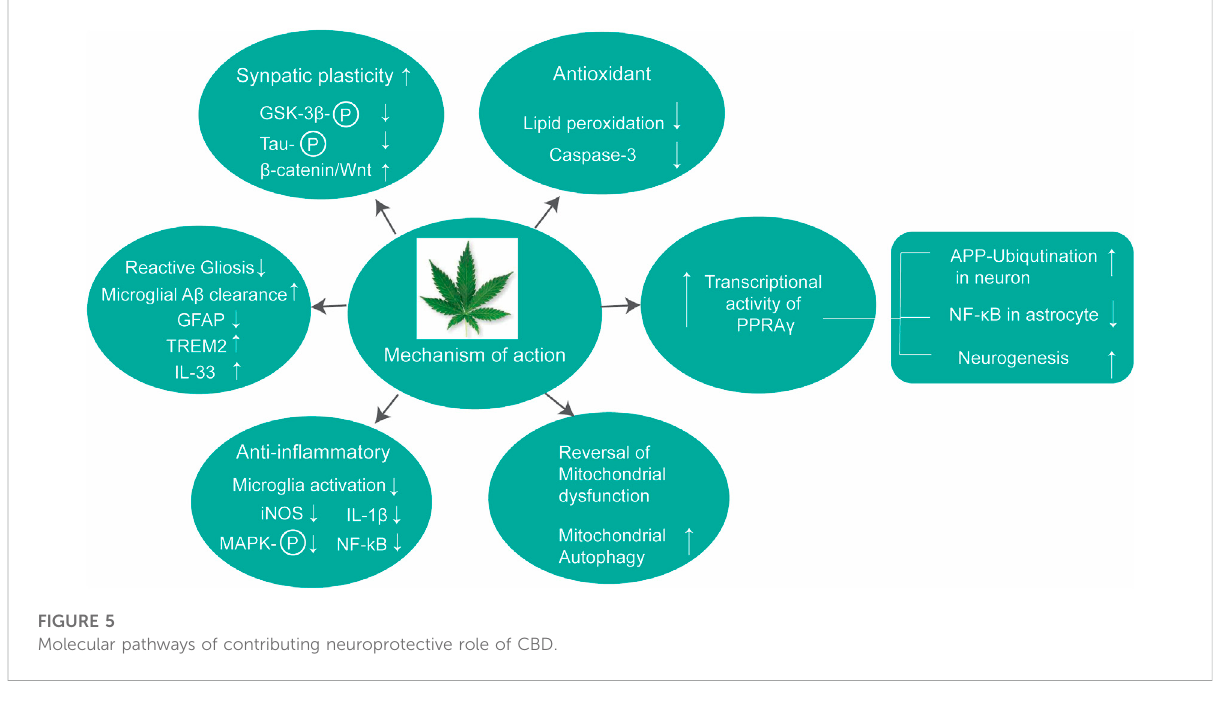
FIGURE 5 Molecular pathways of contributing neuroprotective role of CBD.